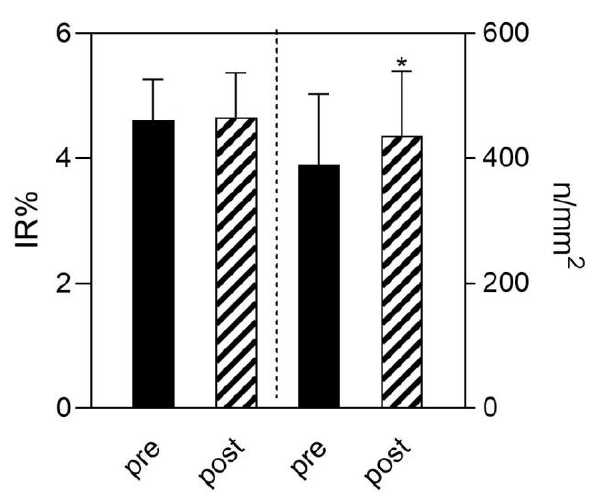
Figure 3. Quantitative analysis of CD1a-immunostained epidermal sections from UMNSCI patients before (pre) and after (post) 2 years of NMES. IR% represents the immunoreactive area occupied in the epidermis by Langerhans cells, while n/mm 2 is their numerical density. Data are mean ± SEM; * = p < 0.05, paired t -test.